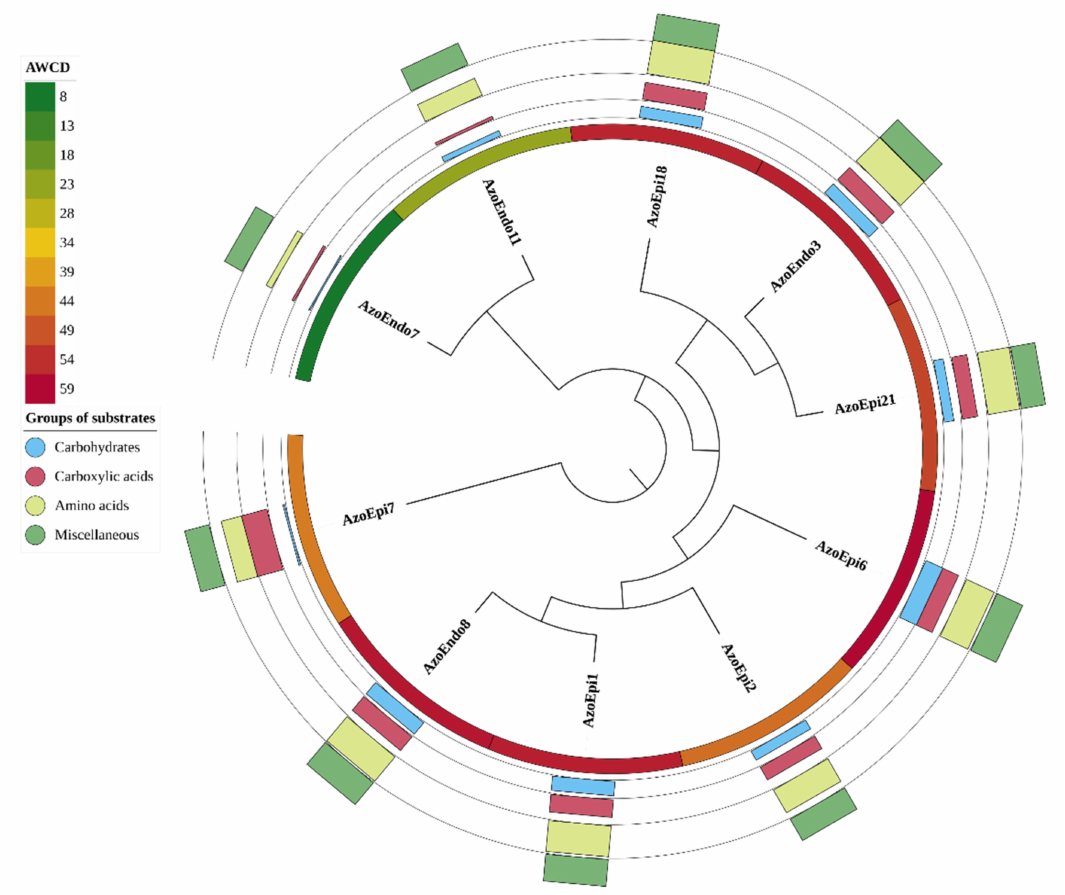
Figure 1. Phenotyping analysis of the studied microorganisms based on the results of GEN III MicroPlates ™ analysis. Clustering analysis tree created on the basis of the results of the use of all substrates after the correction with negative reaction control (UPGMA, Euclidean similarity index). Inner circle (color gradient) presents AWCD—average well color development. Multivalued bar charts present the percent use of different groups of substrates: carbohydrates, carboxylic acid, amino acids, and miscellaneous (each line presents a different group of substrates, as shown in the